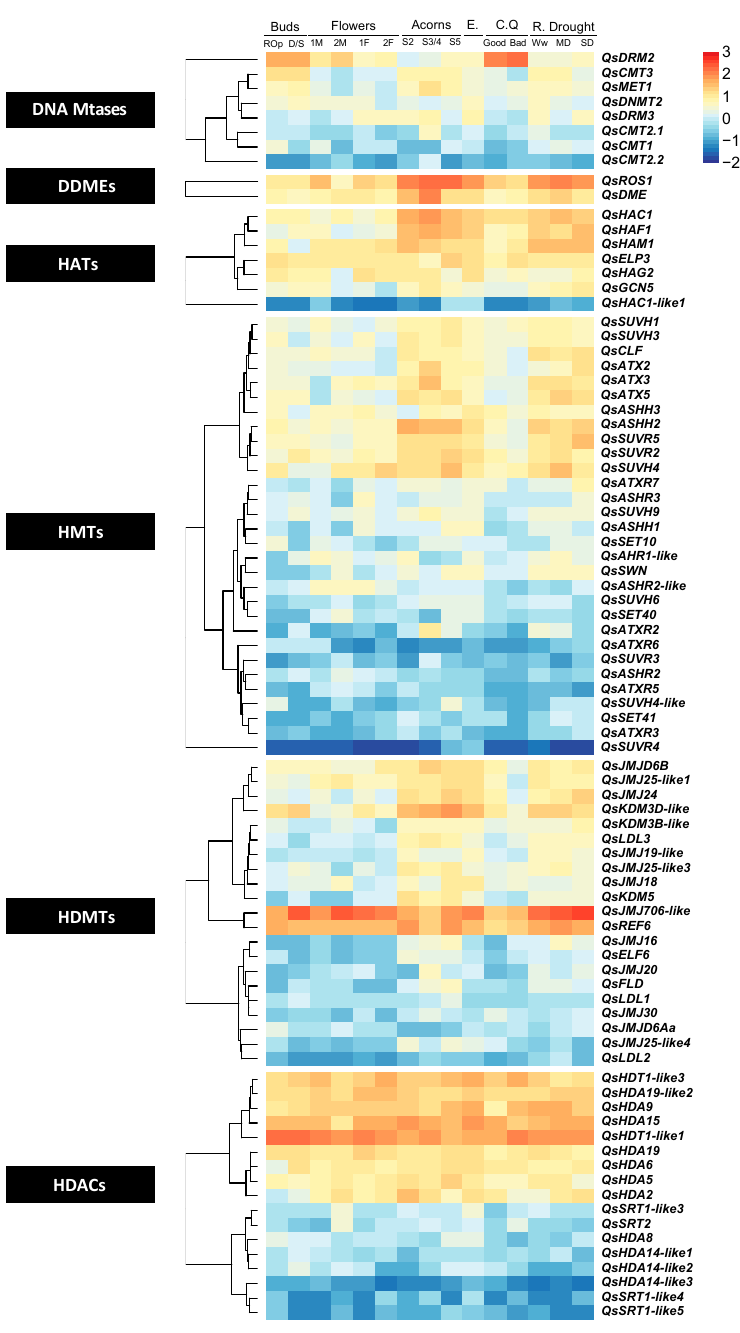
Figure 8. Expression profiles of the homologs of DNA methyltransferases, DNA demethylases, histone acetyltransferases, histone methyltransferases, histone acetylases, and histone demethylases in Quercus suber L. The expression levels of the epigenetic regulators identified in diverse Q. suber published databases were analyzed after mapping the 454 reads derived from the RNA sequencing of several tissues (categorized on the top) to the Q. suber genome and the corresponding read count normalization. The tissues with available libraries include: acorns in 3 development stages (S2, S3 / 4, S5) [48], embryos (E) [48], good and bad quality cork (C.Q) [49], early (1F and 1M) and late stages (2F and 2M) of female (F) and male flower (M) development [50], roots (R.) with medium (MD), severe (SD) or without drought stress (Ww) [51], samples with red and open buds (ROp) and samples with dormant and swollen buds (D / S) [52]. The results were plotted in an heatmap after Rlog transformation followed by Z-score computation. For interpretation of the expression patterns color, the chart is next to each heatmap. The gene name code was indexed in the heatmap, based on the phylogenetic analysis